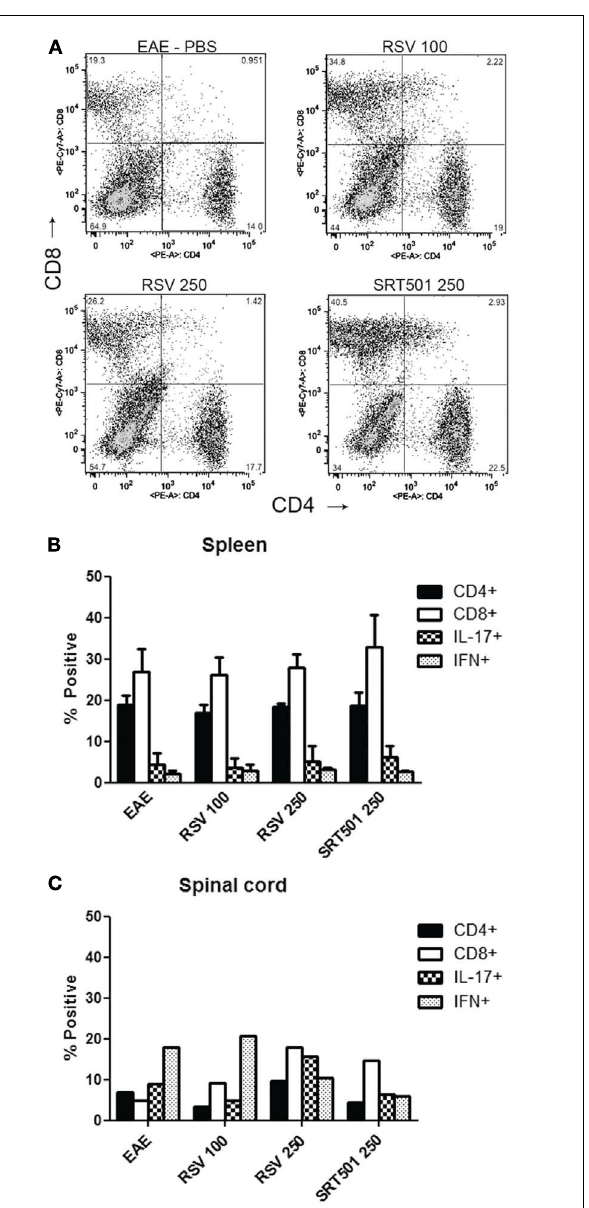
FIGURE 6 | Resveratrol does not suppressT cells in the periphery or CNS. Total cells were isolated from the spleens of individual EAE mice treated with PBS alone, 100mg/kg RSV, 250mg/kg RSV, or 250 SRT501 daily until day 30 post-immunization. (A) Freshly isolated cells stained with antibodies to CD4 and CD8 were analyzed by flow cytometry. Representative plot for one mouse in each treatment group shows identifiable populations of CD4 + and CD8 + T cells. (B) The average percentage of CD4 + and CD8 + T cells found in EAE spleens ( N = 4 mice/treatment group), and the percentage of CD4 + cells that stained positive for IL-17 and IFN-gamma, is shown. No difference is observed between treatment groups. (C) Spinal cords from mice in each treatment group ( N = 4) were pooled together to ensure sufficient numbers of inflammatory cells for flow cytometry. Less than 10% of spinal cord mononuclear cells from each treatment group were CD4 + T cells.Within the CD4 + T cell population, 5–15% were IL-17 + and 10–20% were IFN-gamma + , with too few cells present for statistical